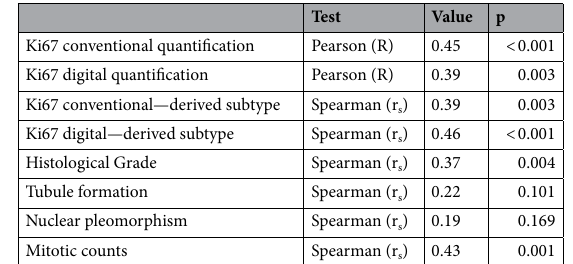
Table 3. Correlation of variables with Oncotype Dx test, showing the test used in each parameter, its value and the significance